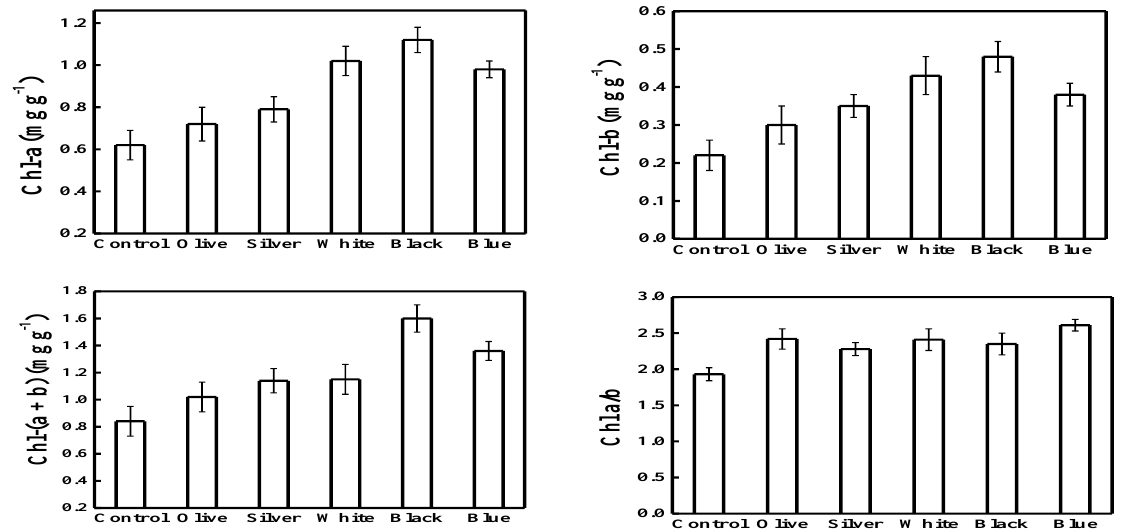
Fig. 4. Effects of different types of plastic films on leaf chlorophyll content in lettuce. Each histogram represents a mean value of three independent experiments and the vertical bars indicate SE (n = 3)